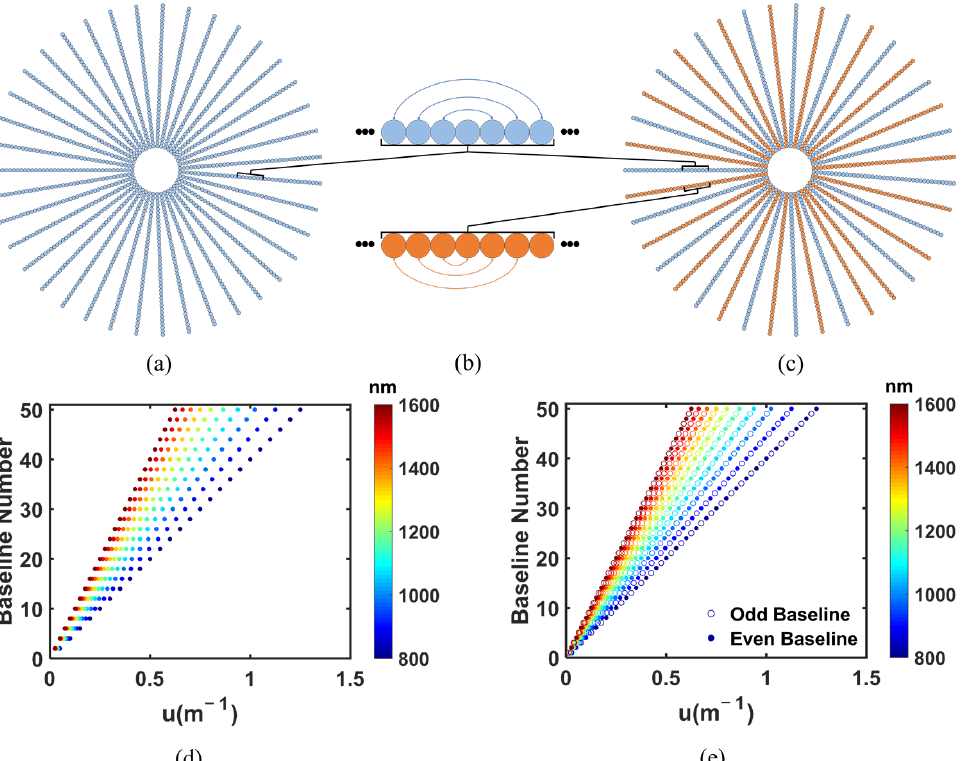
Figure 1. Differences in structure and frequency between traditional SPIDER and the parity-baseline segmented planar imaging system. ( a ) Structure of the conventional SPIDER; ( b ) Method of parity baseline selection; ( c ) Structure of the parity-baseline segmented planar imaging system; ( d ) The u-v frequency components of the conventional SPIDER; ( e ) The u-v frequency components of the parity-baseline segmented planar imaging